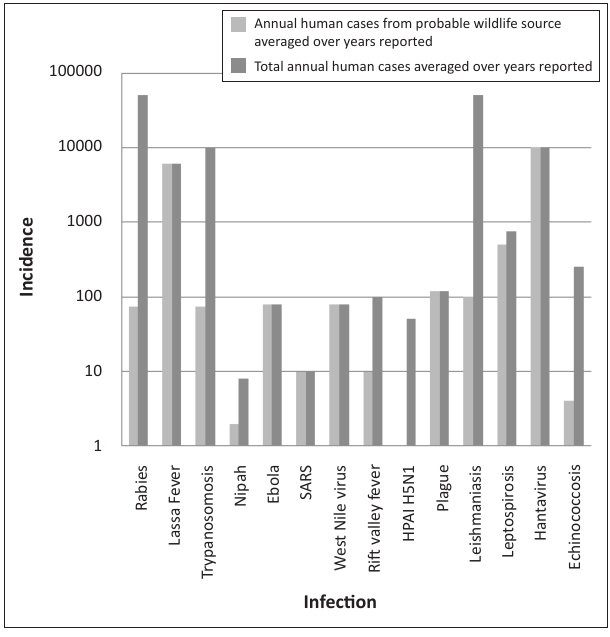
FIGURE 1: Global mortality estimates of infections from a wildlife source in humans as a proportion of total incidence.